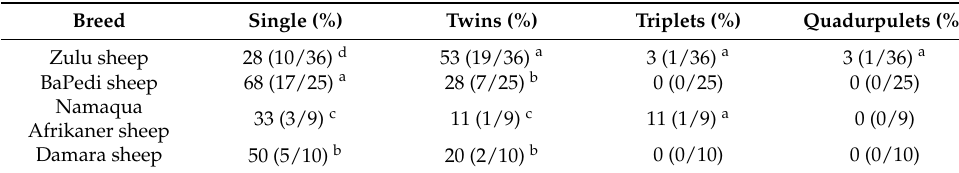
Table 9. Litter size of South African indigenous sheep [43].